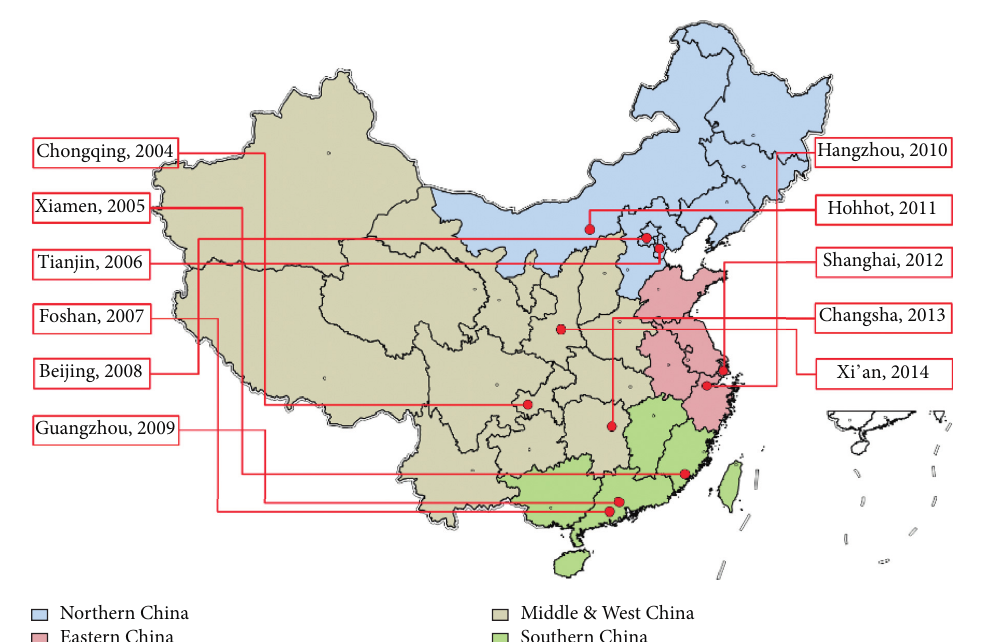
Figure 1: The collected cases of CO emission factors for GM (1, 1) model.